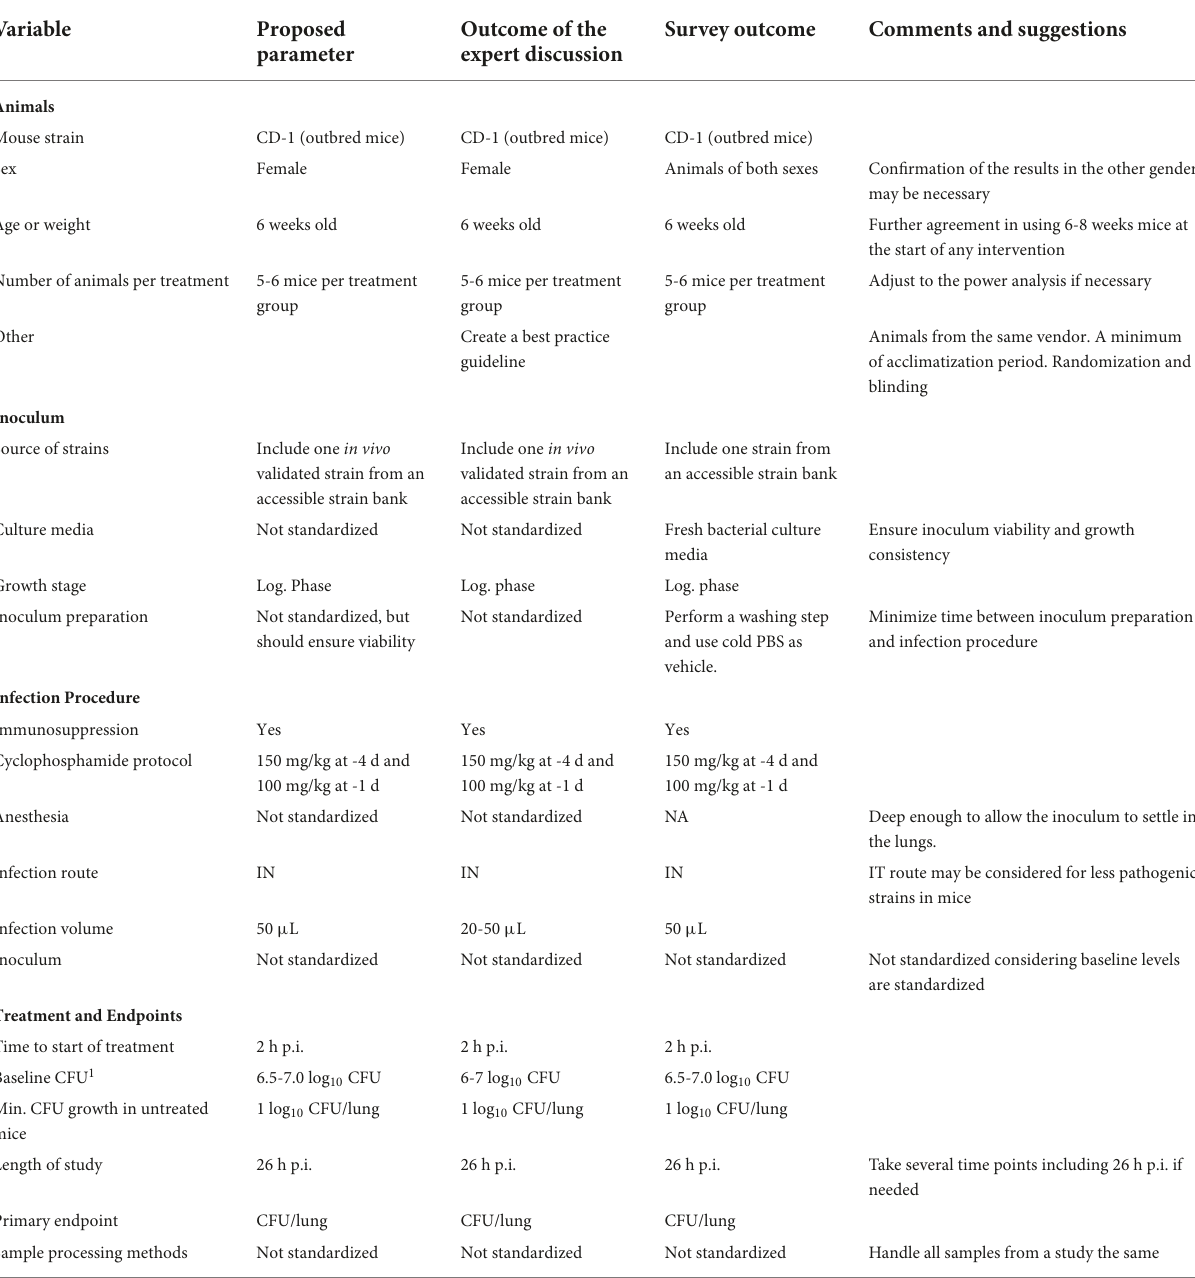
TABLE 1 Summary of standard variables proposed by COMBINE experts, panel discussion and survey